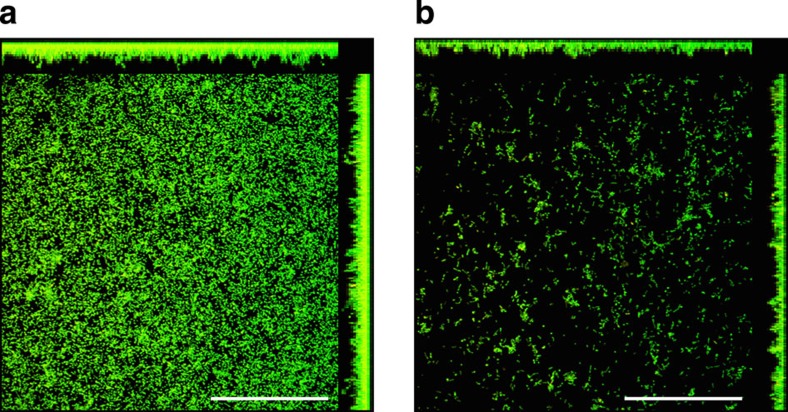
Biofilm formation using modA2ON and OFF strains.(a) Shows biofilm formation using modA2(22)ON. (b) Shows biofilm formation using modA2(24)OFF after 24 h growth on chambered coverglass and visualized using confocal microscopy following LIVE/DEAD BacLight staining. Scale bar shown represents 50 μm.